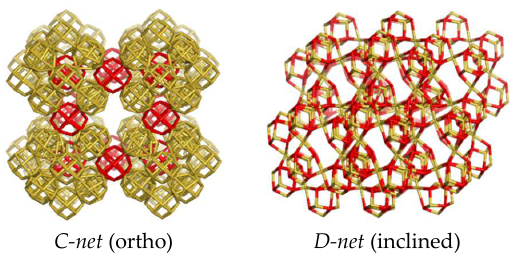
Figure 2. Corner-coalesced cube nets.